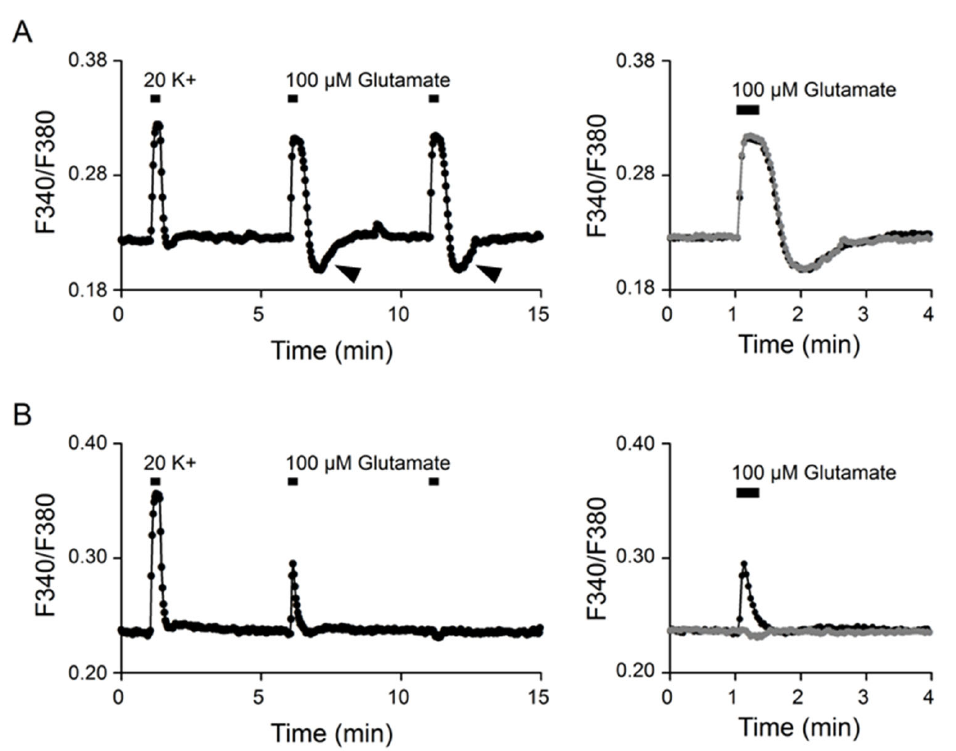
Figure 1. Tonic and transient Ca 2+ responses to glutamate. ( A ) A representative experiment (an average of 15 cells) showing the tonic Ca 2+ response to 100 µ M glutamate ( left ). Note the rebound Ca 2+ suppression (marked by arrowheads). Right panel superimposes the two consecutive glutamate responses to indicate the nearly identical kinetics, with rapid Ca 2+ rise, to reach a plateau during the 20 s application of glutamate. ( B ) A representative experiment (an average of 17 cells) to show the transient Ca 2+ responses to glutamate ( left ). Note the variable Ca 2+ responses to the two consecutive application of glutamate. Right panel superimposes the two Ca 2+ responses to indicate the totally different kinetics, one with transient Ca 2+ increase (dark trace) and another with delayed Ca 2+ decrease (grey trace). Note the similar kinetics of the Ca 2+ responses to 20 mM K + in the two representative experiments ( A , B ).